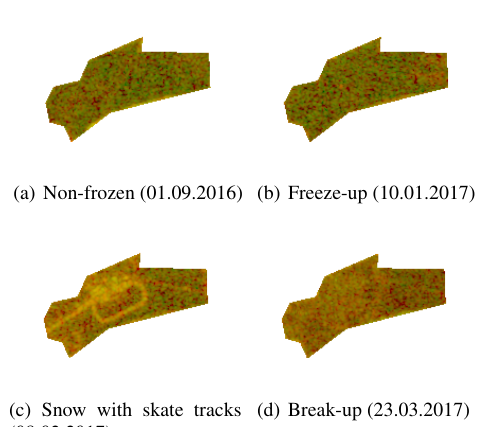
Figure 1: Examples of RGB composites of Sentinel-1 SAR data (RGB = [ VV, VH, 0 ]) of lake St. Moritz showing the lake in the four different states specified in the sub-captions.